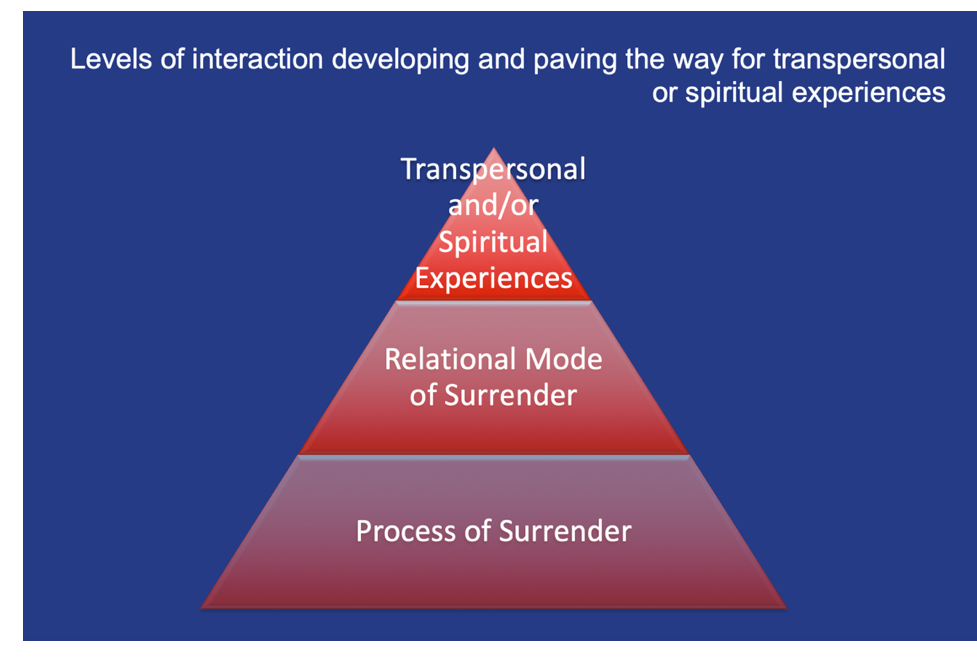
FFigigururee 88 Levels of Interaction Preparing for Experiences with Transpersonal or Spiritual Character. Note:From Mårtenson Blom (2014, p.